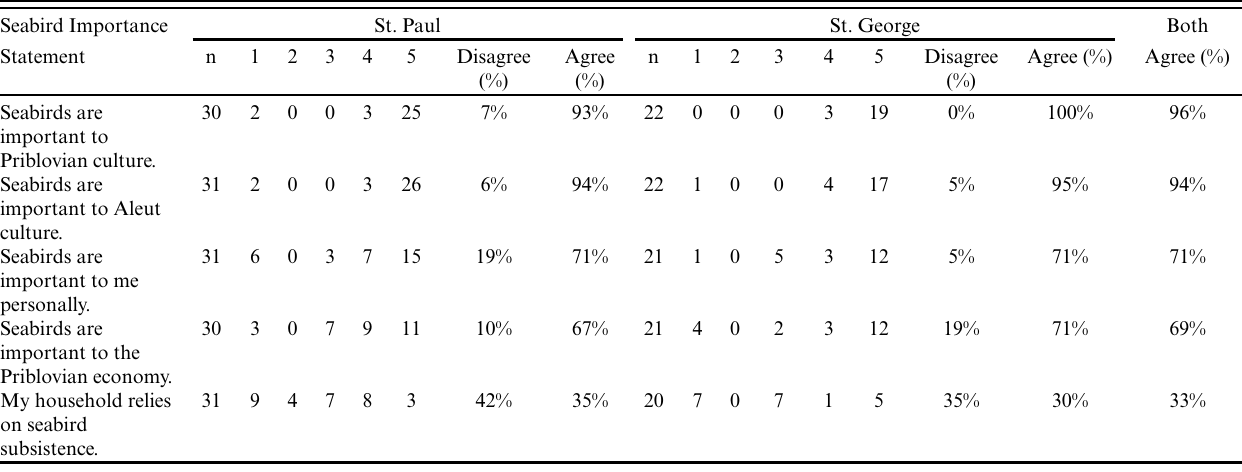
Table 2 . Survey responses to questions about the importance of seabirds. For each island the sample size (n) responding to each question is given, along with the responses broken down according to the Likert scale: 1 = Disagree; 2 = Somewhat Disagree; 3 = Neither; 4 = Somewhat Agree; and 5 = Agree. For each statement the percent of responses agreeing and disagreeing is provided for each community. The last column indicates the percentage of responses in agreement with the statement in the entire